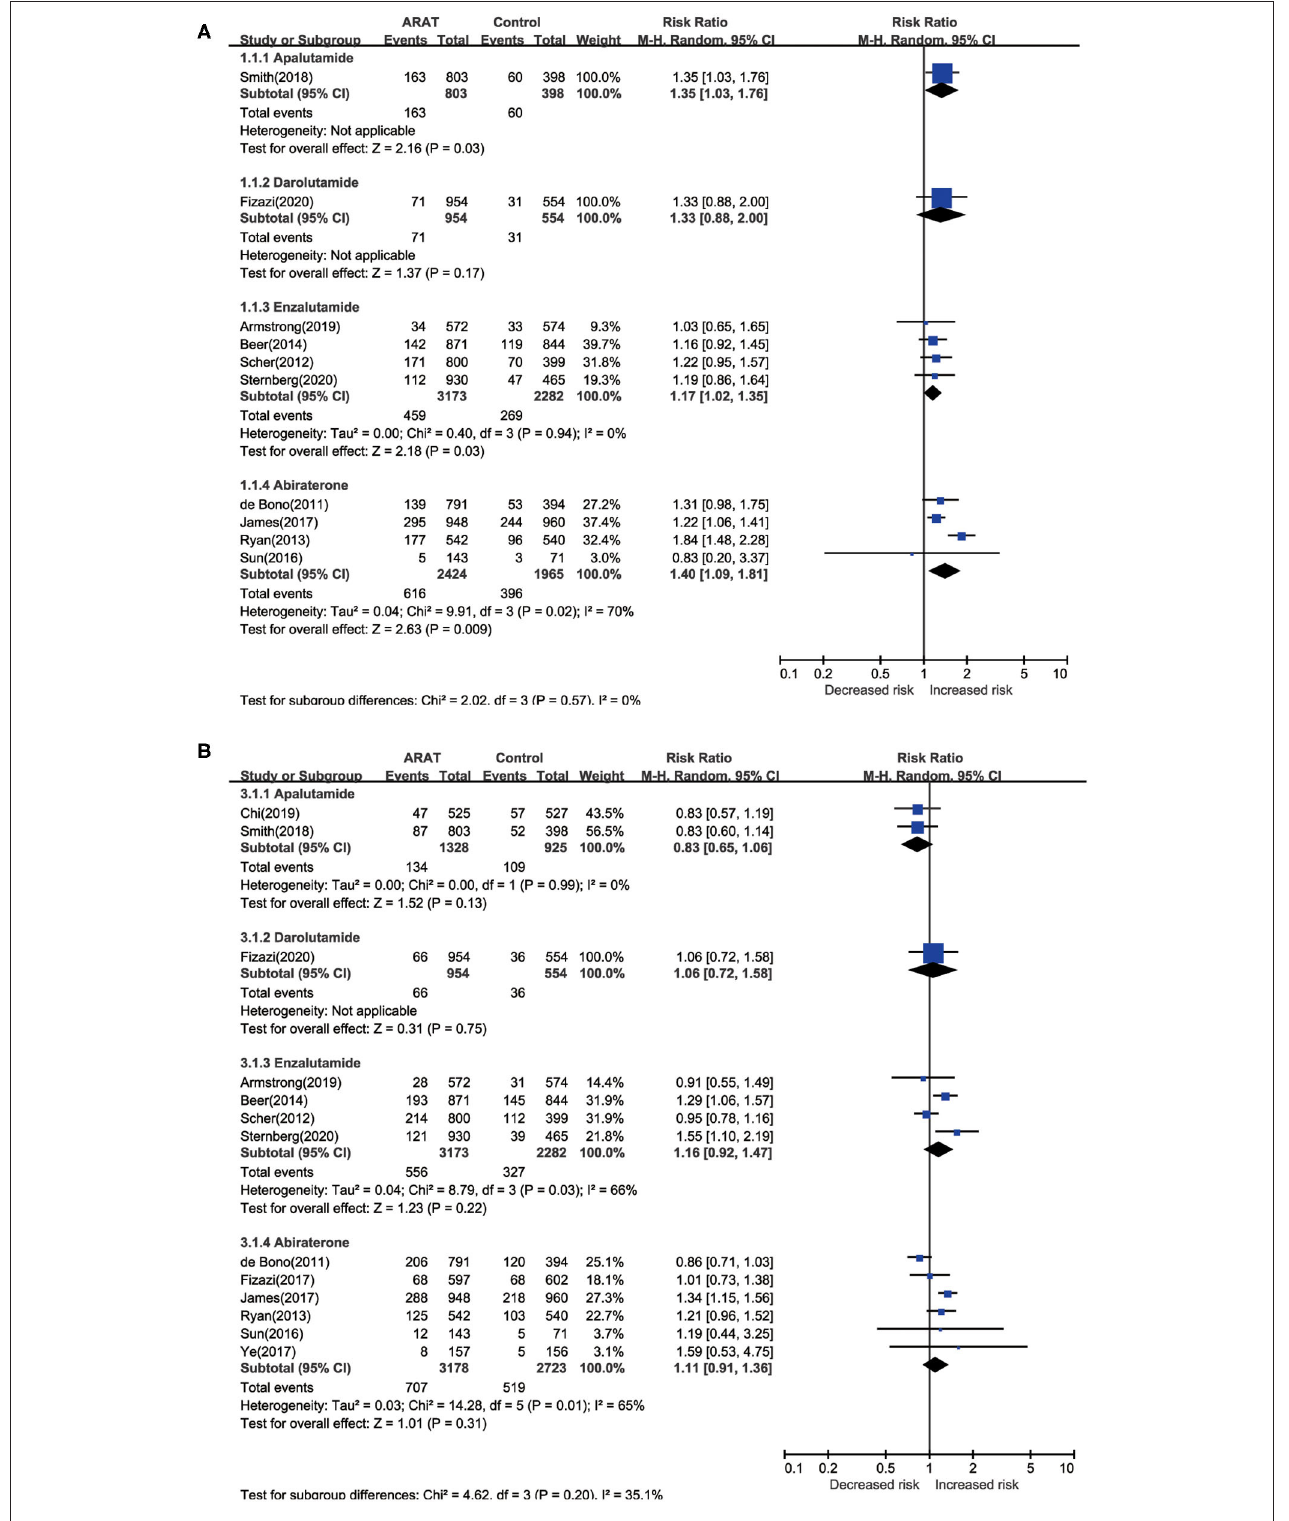
FIGURE 3 | Pairwise meta-analysis for risk of diarrhea and constipation among included ctudies. (A) Diarrhea; (B) constipation.